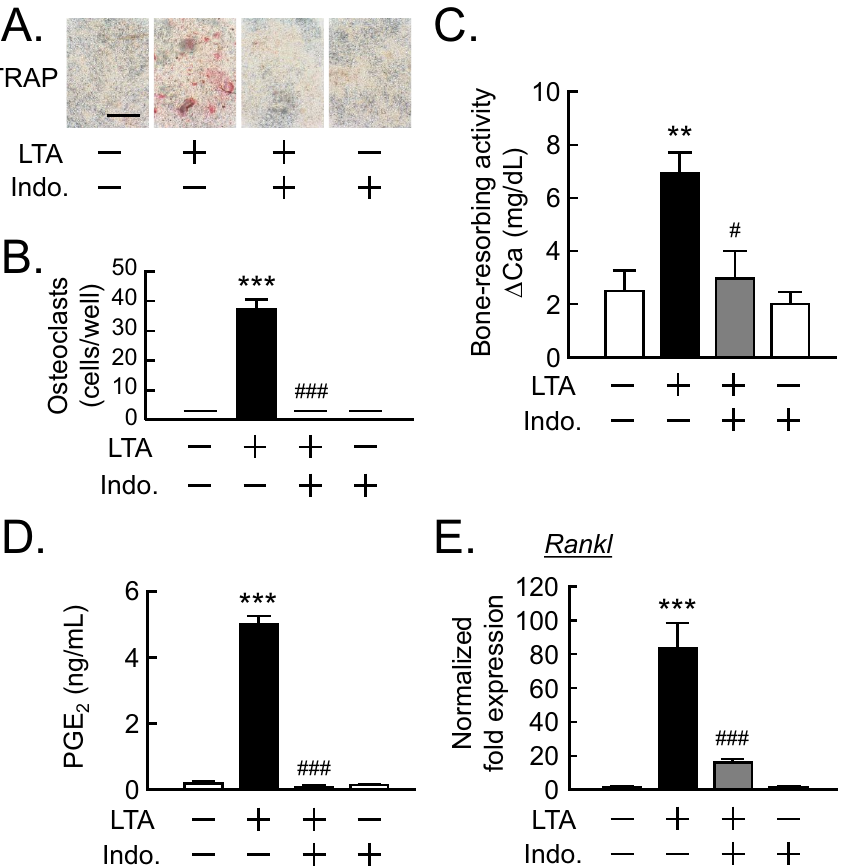
Figure 3. Effects of indomethacin on LTA-induced bone resorption. ( A ) Mouse POB and BMCs were co-cultured with or without LTA (100 μg/mL) and indomethacin (10 μM) for 6 days. The images showed TRAP- positive multinuclear osteoclasts. Scale bar: 500 μm. ( B ) TRAP-positive multinuclear osteoclasts were counted. The data are expressed as the mean ± SEM of 3 wells. ( C ) Mouse calvariae from newborn mice were cultured with LTA (100 μg/mL) and indomethacin (10 μM) for 5 days. The calcium concentration was measured to elucidate bone-resorbing activity. The data are expressed as the mean ± SEM of 5 wells. ( D ) Mouse POBs were cultured with LTA (100 μg/mL) and indomethacin (10 μM) for 24 h, and the level of PGE 2 in the conditioned medium was measured. The data are expressed as the mean ± SEM of 3 wells. ( E ) Mouse POBs were cultured with LTA (100 μg/mL) for 24 h and total RNA was extracted and the mRNA expression of RANKL was analyzed by qPCR. The data are expressed as the means ± SEM of triplicate from a representative experiment. β-actin was used as a normalized gene. A significant difference between the two groups was indicated; ** P < 0.01 and *** P < 0.001 versus control, # P < 0.05 and ### P < 0.001 versus LTA; by one-way ANOVA and Tukey’s post hoc